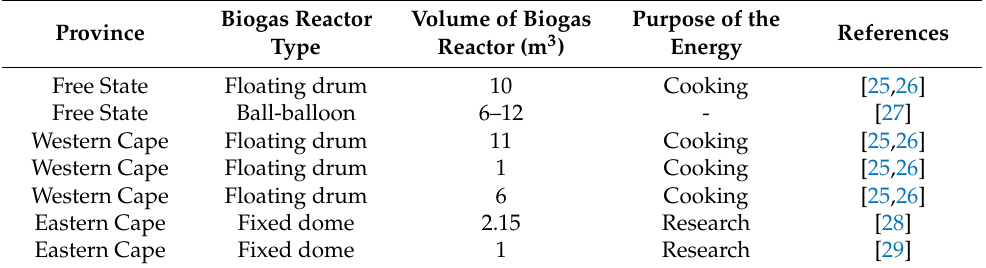
Table 2. Selected biogas reactor types and their respective volumes in South